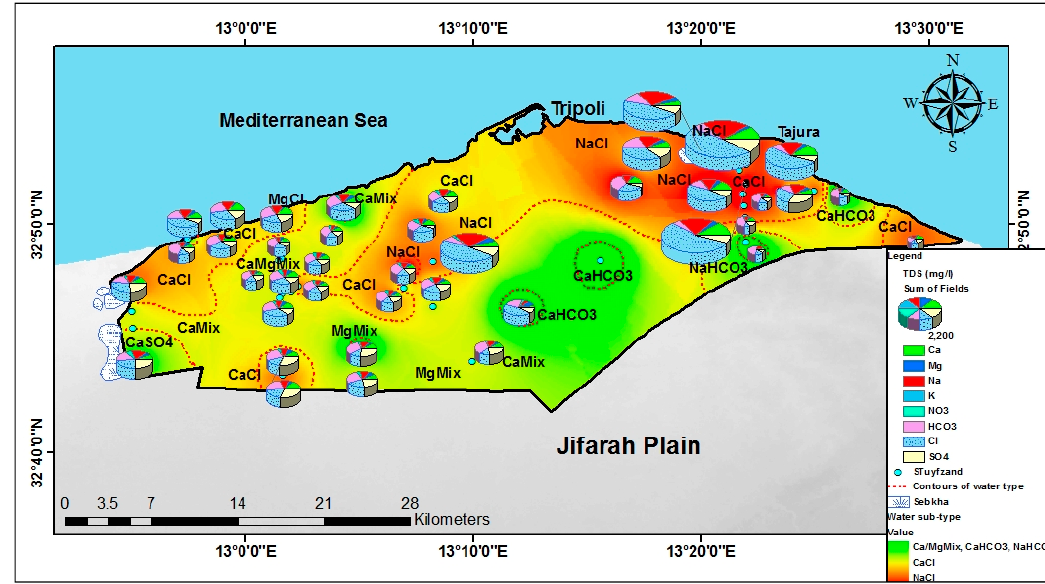
Figure 9. Distribution of water types according to Stuyfzand with a plot of TDS concentration for selected representative samples in Tripoli.